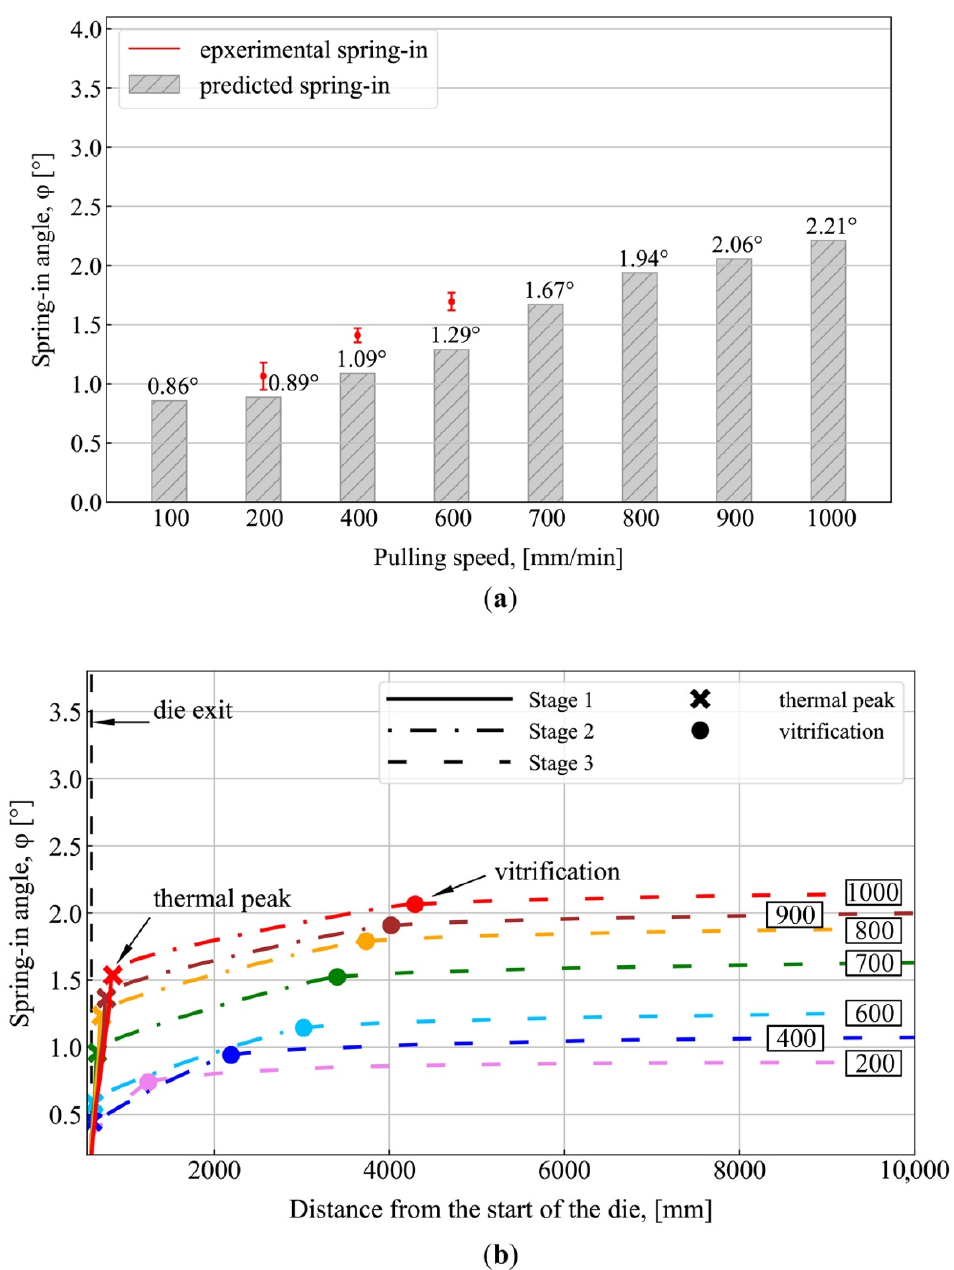
Figure 6. Numerical simulation results: ( a ) Final values of spring-in at the die exit for different pulling speeds, assuming the constant Poisson’s ratio of matrix; ( b ) Spring-in evolution during fabrication for different pulling speeds, assuming the constant Poisson’s ratio of matrix. The solid lines in ( b ) correspond to Stage I (spring-in evolutions from the moment the profile exits the die block and to the exothermic peak occurrence); the dot–dash line corresponds to Stage II (from the exothermic peak occurrence and to the vitrification point); the dashed line corresponds to Stage III (after vitrification and to the full cooldown of the profile); the bold cross marks the occurrence of the exothermic peak; the bold point marks the vitrification point; the values shown in rectangles correspond to pulling speed (mm/min).